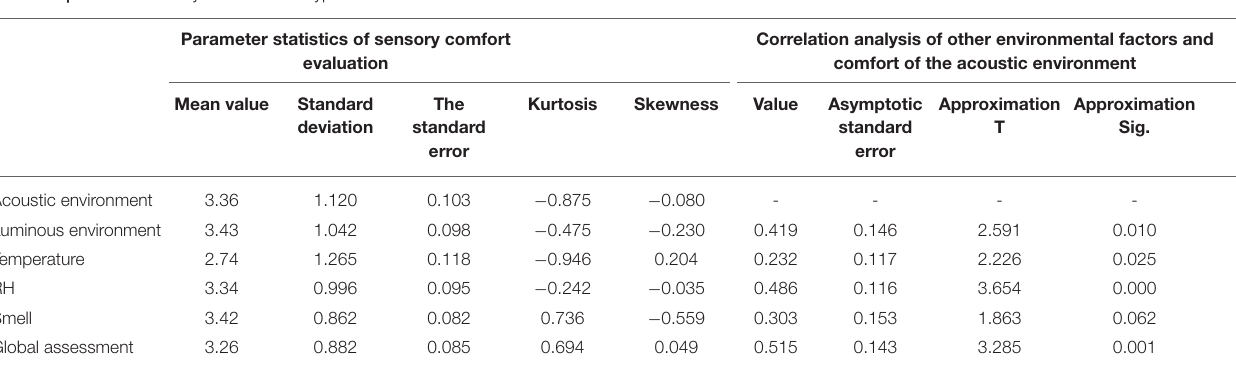
TABLE 6 | Correlation analysis of different types of environmental